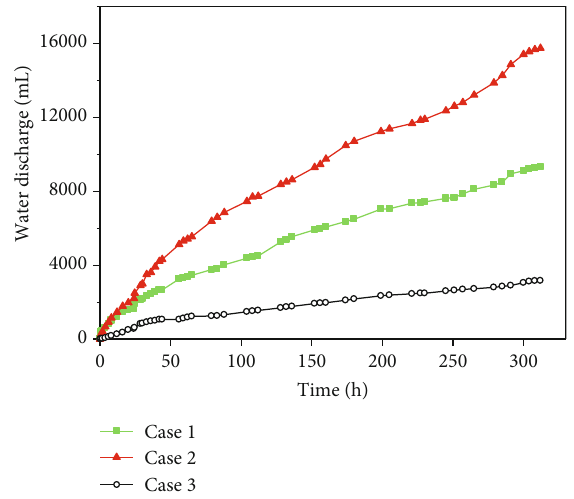
Figure 9: Curve of water discharge with